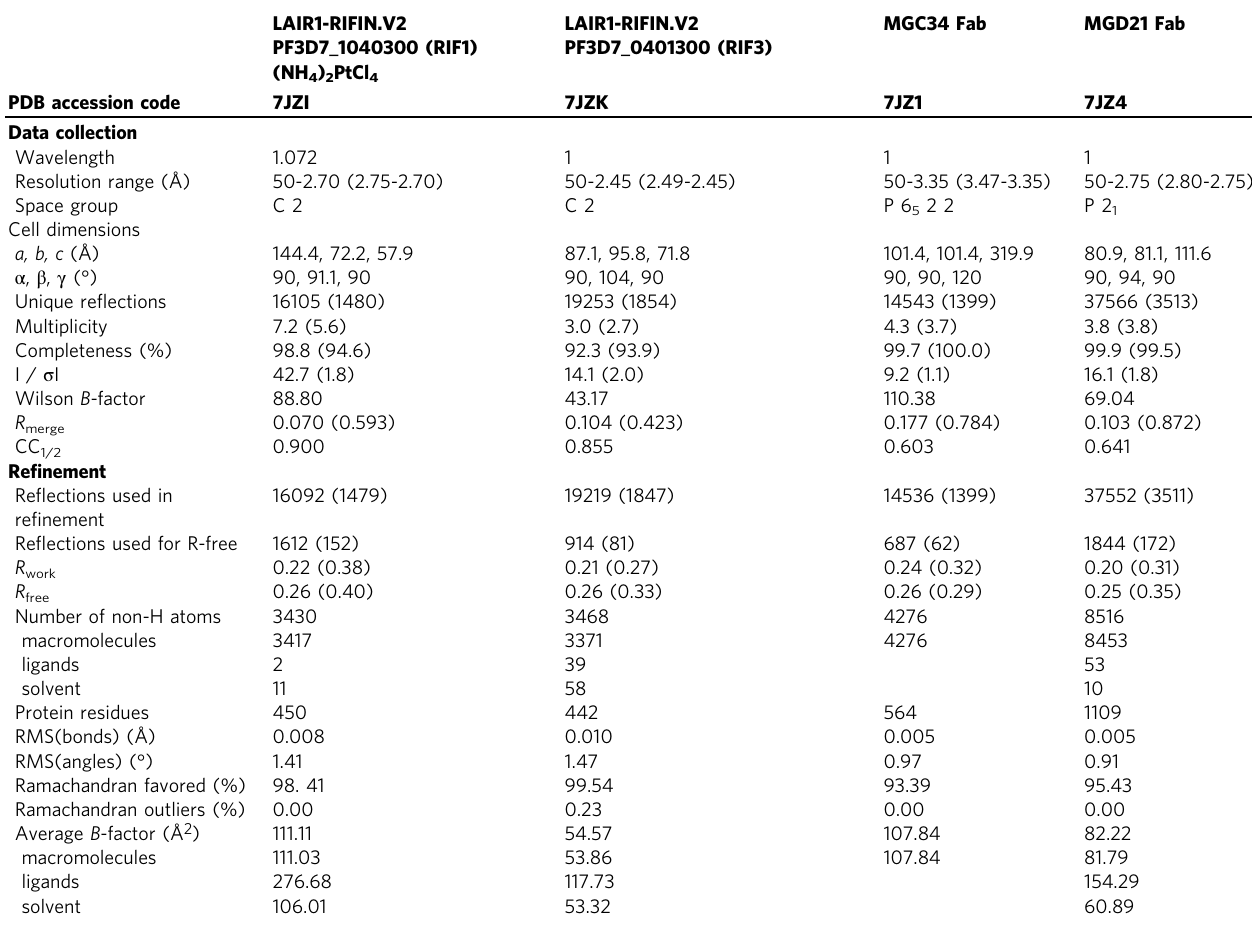
Table 1. Statistics of X-ray diffraction data collection and structural re fi